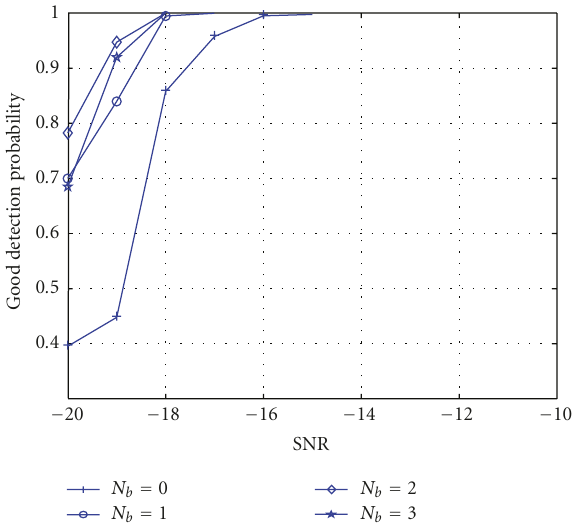
Figure 2: Estimation of the good detection probability for DVB-T signals, mode 8k, with η = 1 / 32 and an observation time equal to 50